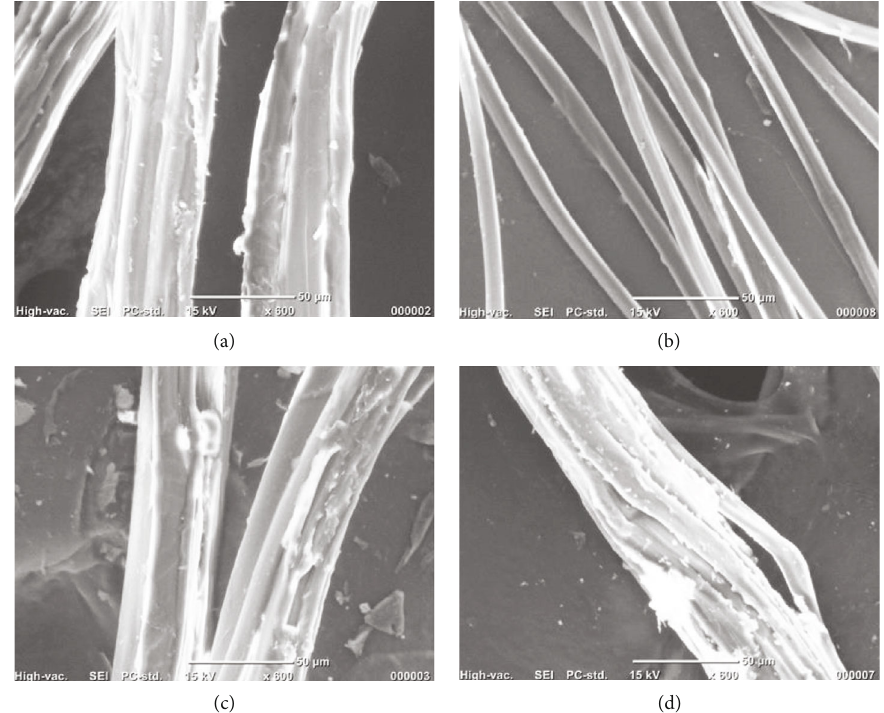
Figure 4: SEM observation of uncross-linked and cross-linked NCS fi lament before and after degumming. (a, b) Uncross-linked fi ber before and after degumming; (c, d) cross-linked fi ber before and after